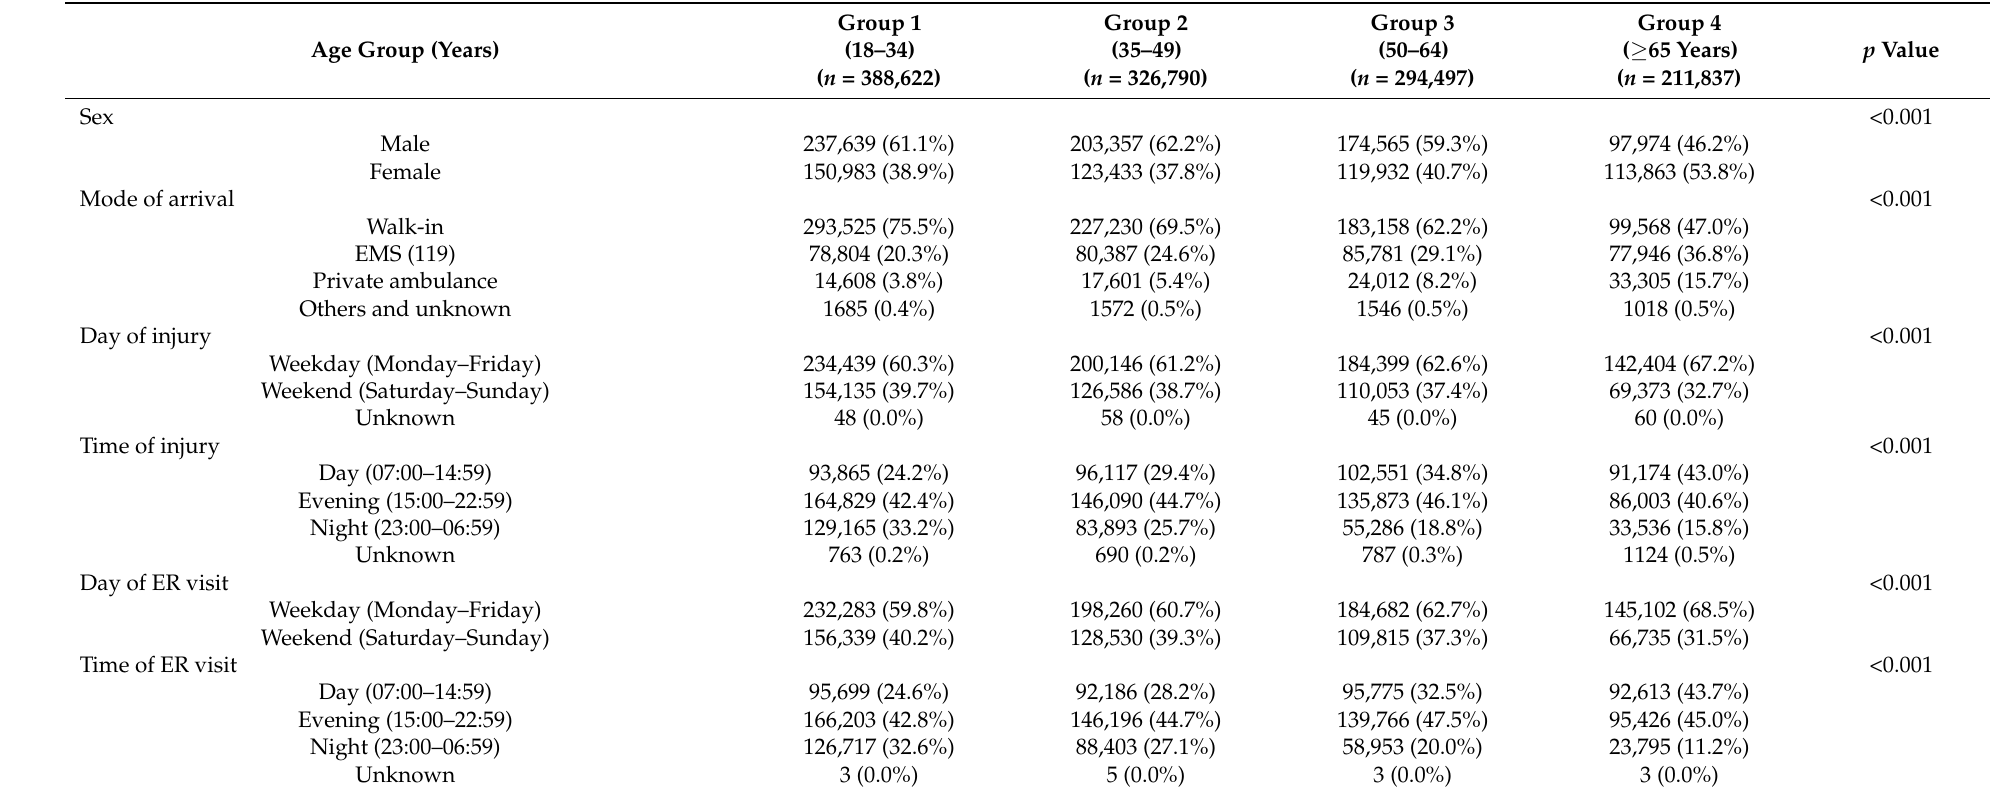
Table 1. General characteristics of injury patients by age